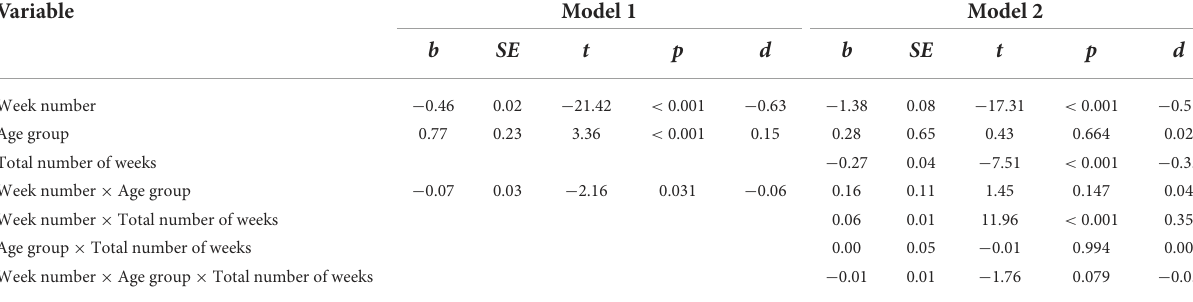
TABLE 6 Fixed main and interaction effects of age group and total number of weeks on rates of change in anxiety symptoms.